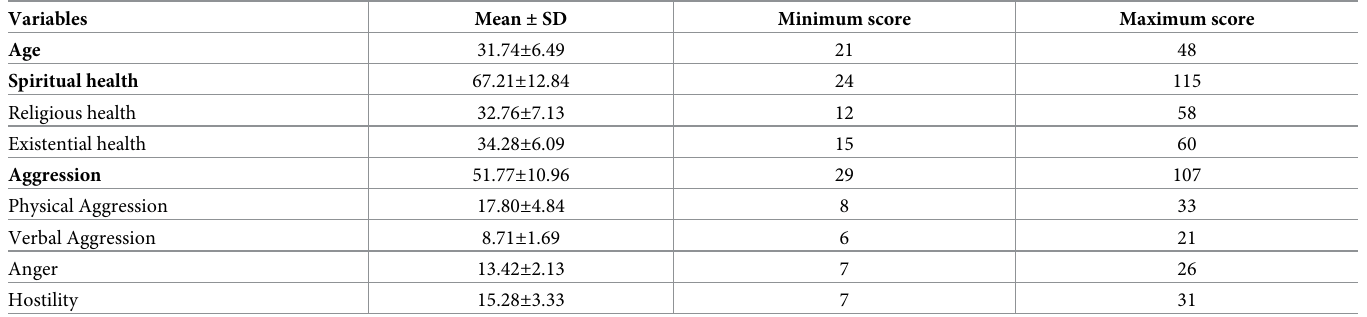
Table 2. Description of the spirituality and aggression.